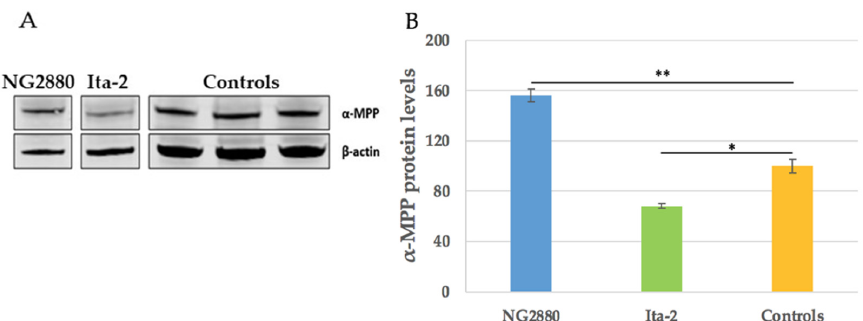
Figure 2. Protein levels of alpha subunit of mitochondrial processing peptidase ( α -MPP) in the two Italian patients with intermediate phenotypes versus controls (average of three healthy subjects). ( A ) Representative Western blot of α -MPP and β -actin (as normalizer). ( B ) Densitometric analysis from three independent experiments. Protein levels in patients are represented as percentage of control (average of three healthy controls) set at 100. Error bars indicate standard error of the mean (SEM). * p < 0.05; ** p < 0.01.